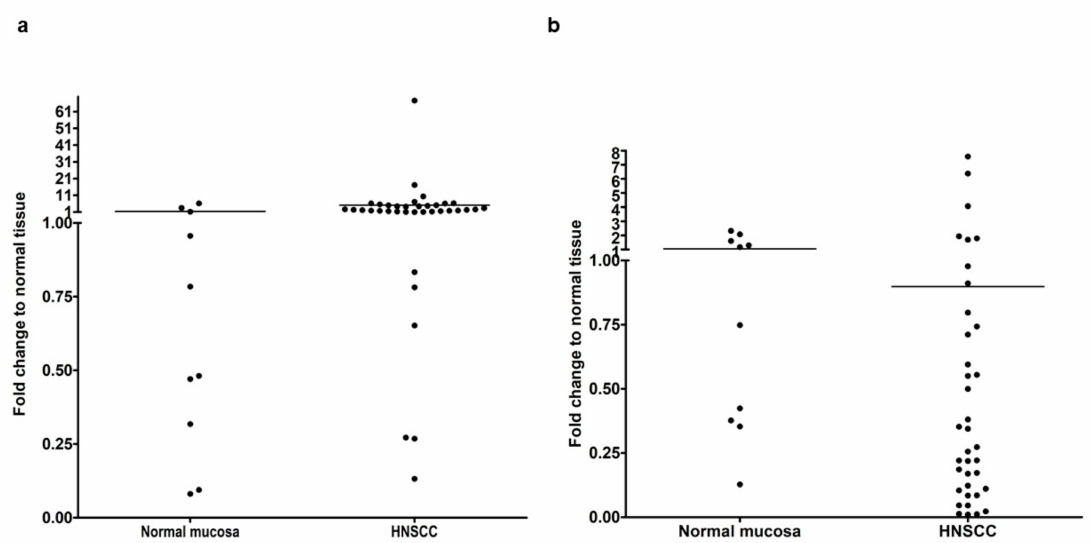
Figure 1. Comparison of relative quantification of Slug ( a ) and KLF4 ( b ) gene expression in normal mucosa and in HNSCC. Ten normal mucosa and 37 HNSCC samples were used for real-time PCR analysis. On the Y -axis the fold change difference to the mean reference value of normal mucosa is presented. None of the compared sample sets showed normal distribution. The medians of control and HNSCC samples were compared using Mann-Whitney-test. Slug gene expression was significantly higher in HNSCC than in normal mucosa ( p = 0.009), whereas, KLF4 gene expression was significantly lower in HNSCC than in normal mucosa ( p =